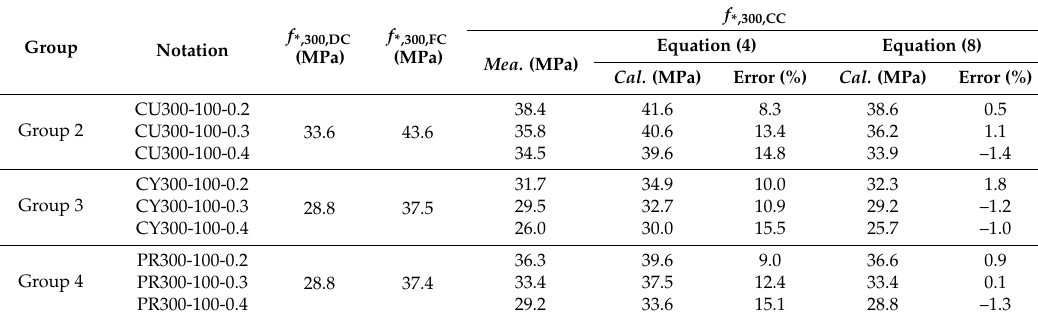
Table 5. Comparison between predicted and measured combined compressive strengths for specimens in Groups 2, 3, and